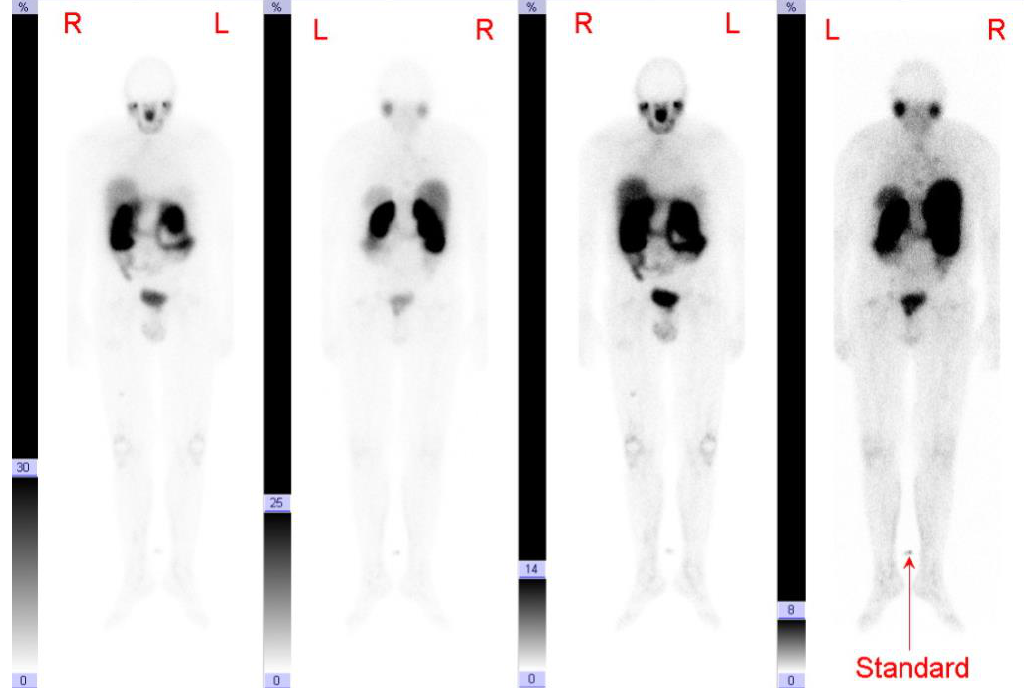
Figure 9. Patient 8. Whole-body-scan 43 h after the second 177 Lu-PSMA application with an intensive nuclide accumulation in the metastases.